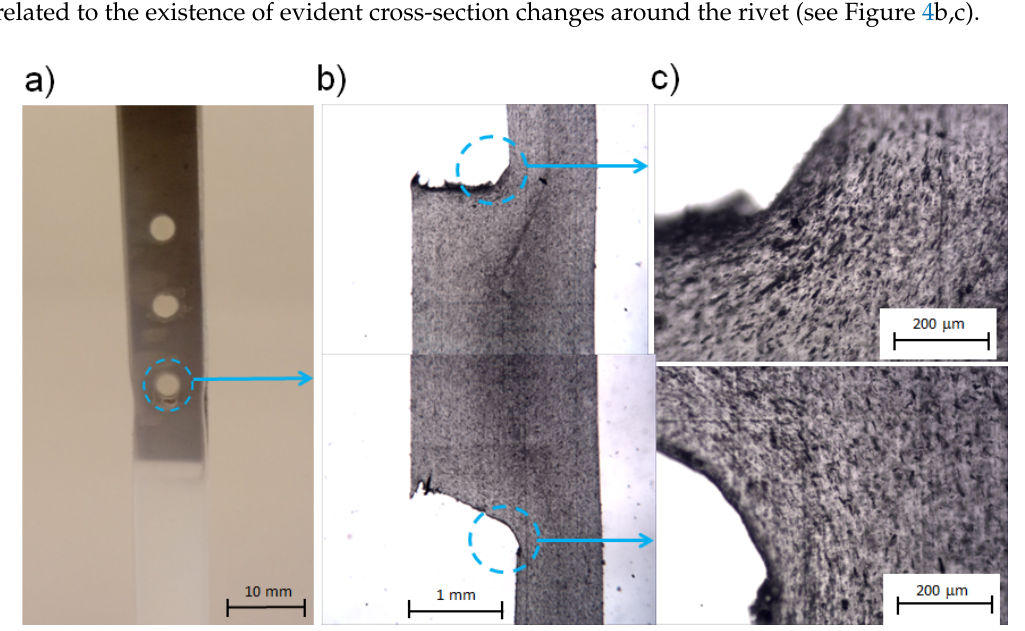
Figure 4. ( a ) Specimen with visible neck formed during uniaxial deformation, neck formation and crack localization under 1st rivet; ( b ) cross-section of single rivet where talc filler was used as polymer-flow marker; ( c ) visualization of talc-particle arrangement (dark short lines) in sample region located under first rivet.